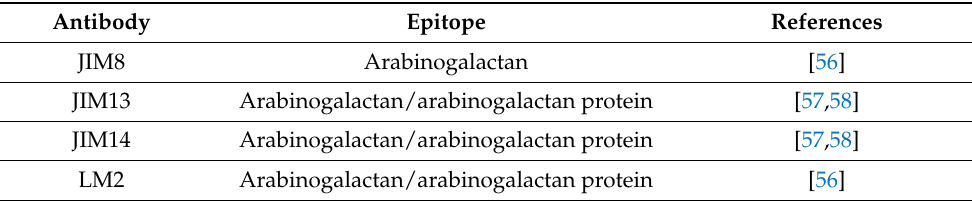
Table 1. Monoclonal antibodies that were used in the current study, the epitopes that they recognize and